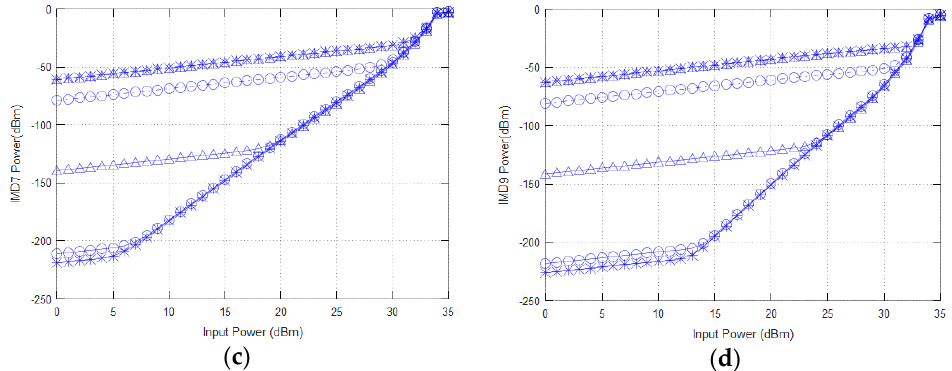
Figure 6. Power in the intermodulation components vs. Input power computed from the periodo- gram with various window functions: Solid o: Hanning window Solid *: Blackman window, Solid ∆ : Blackman Harris window, Dashed o: rectangular window, Dashed *: Hamming window and Dashed ∆ : Kaiser window; ( a ) IMD3, ( b ) IMD5, ( c ) IMD7 and ( d ) IMD9.